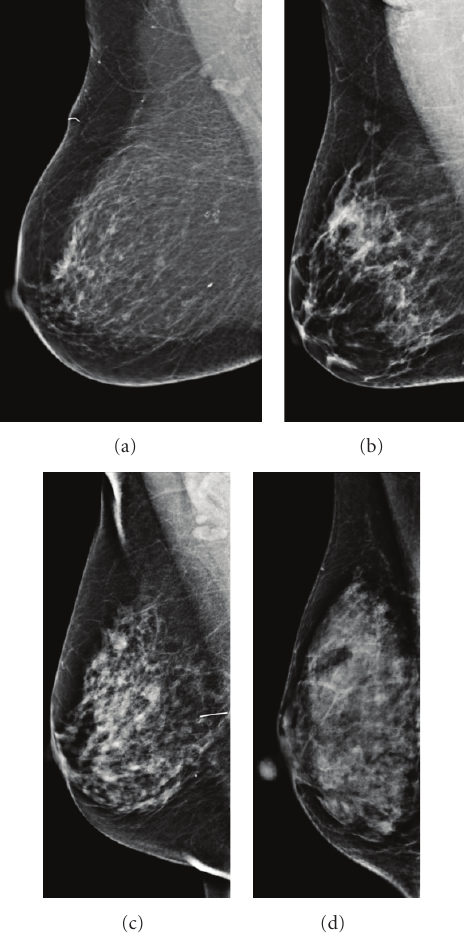
Figure 1: Breast density patterns according to percentage of glandular component: (a) fat (up 25%), (b) fibroglandular (25– 50%), (c) heterogeneously dense (50–75%), and (d) dense (over